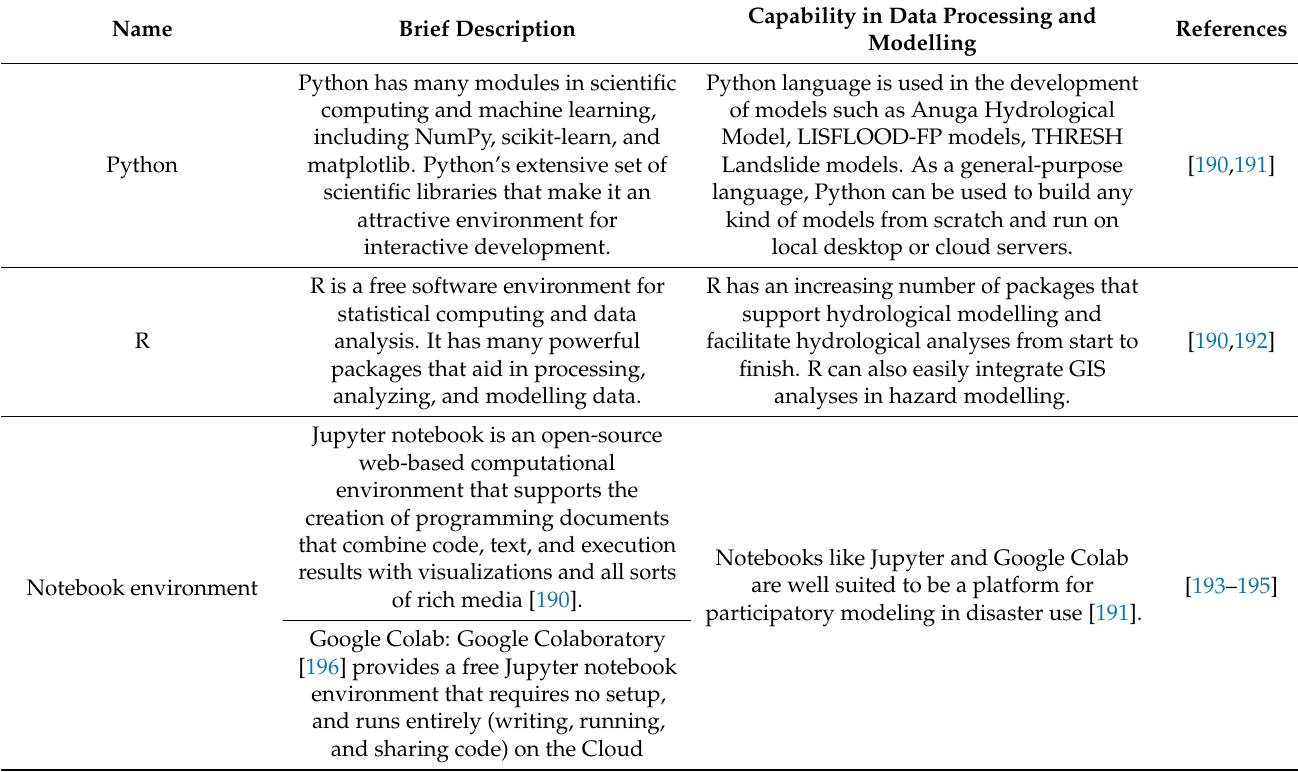
Table 8. Programming languages used for